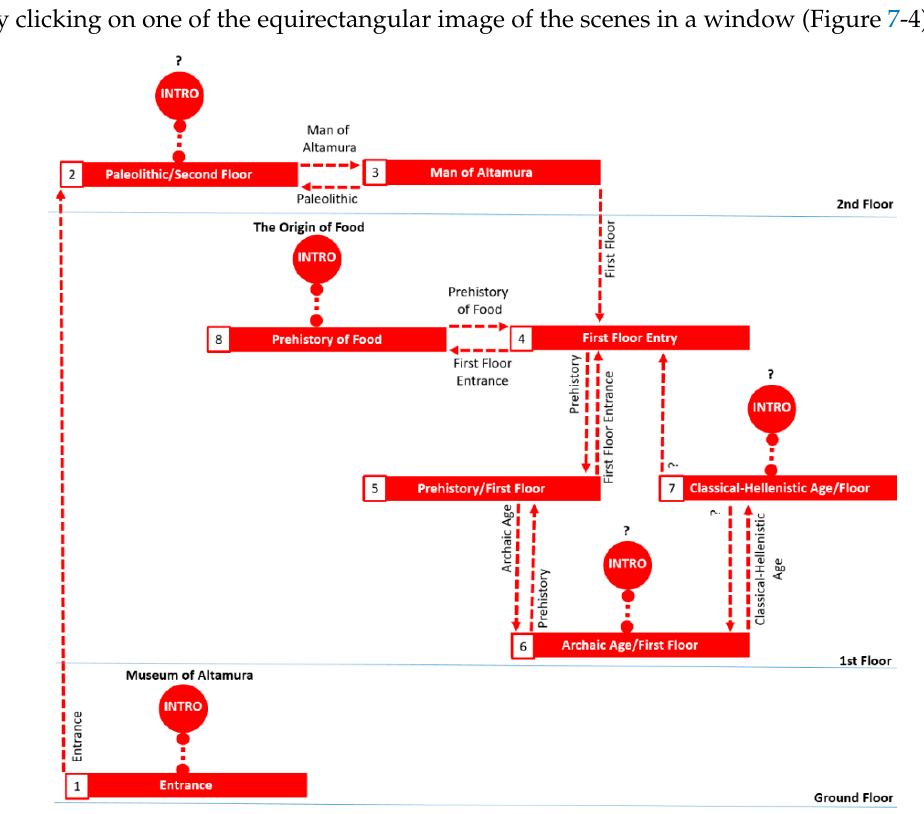
Figure 6. Existing virtual tour of the National Archaeological Altamura Museum: the graph.